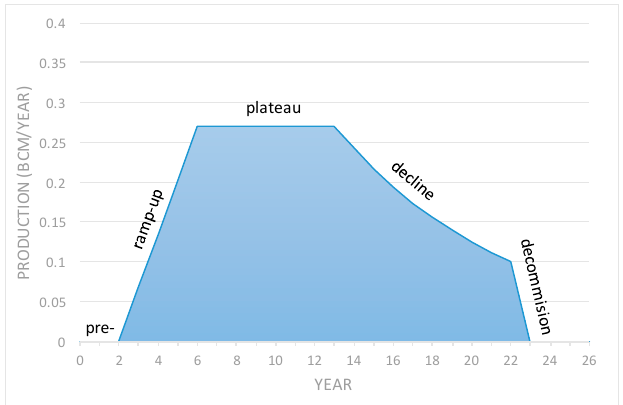
Figure 3. Schematic of a standard production profile for a 4.5 BCM gas field. On plateau, the field produces about 6% of its estimated ultimate recovery (EUR) per year, before production enters a managed exponential decline of 11% per year. The field is decommissioned when its remaining net present value (NPV) drops to zero due to the decline in production.